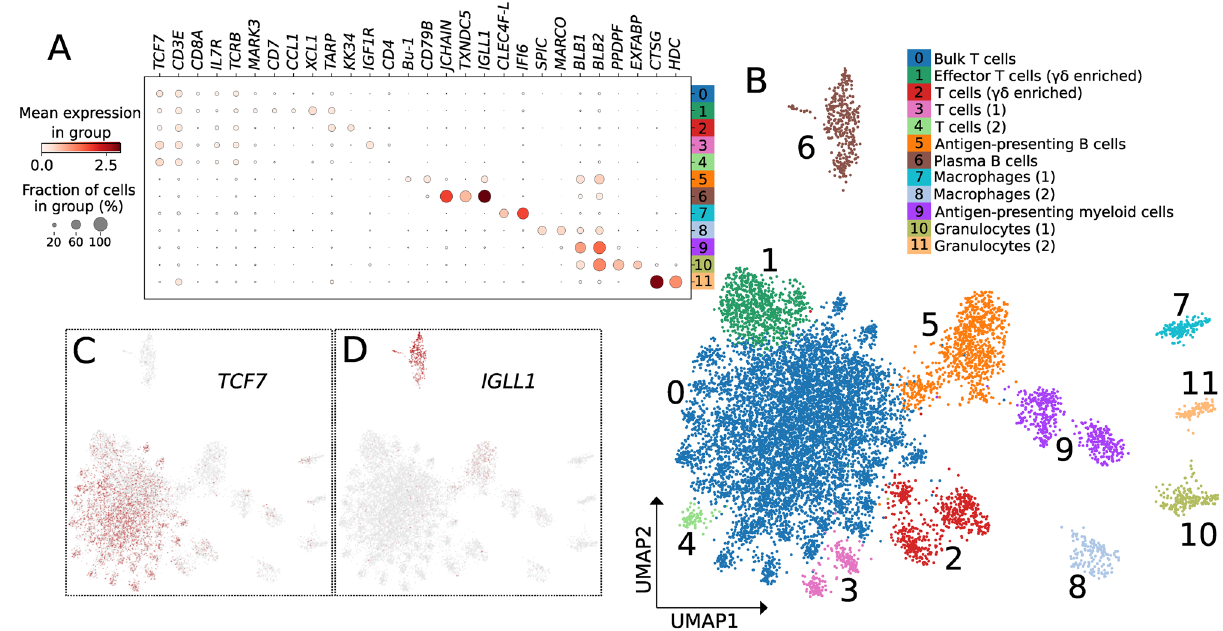
Figure 2. Cell clusters and assigned identities. ( A ) Cluster-specific expression of immune cell marker genes used to assign cell identities to the 12 clusters. Percentage of cells in a cluster expressing a gene (dot size) and mean expression intensity (dot shade) are both represented in this plot. We used these data to assign a cell identity to each numbered cluster, labeled on the right and corresponding to cluster colors in ( B ). ( B ) Uniform manifold approximation and projection (UMAP) plot of all immune cells across samples and conditions. Cells are partitioned into 12 Leiden clusters, numbered and colored based on cluster assignment. ( C , D ) UMAP plots with each cell colored by its level of expression of TCF7 ( C ) and IGLL1 ( D ), demonstrating that some markers are expressed by all subtypes of a more general cell type, such as TCF7 , which is expressed by all Tcell